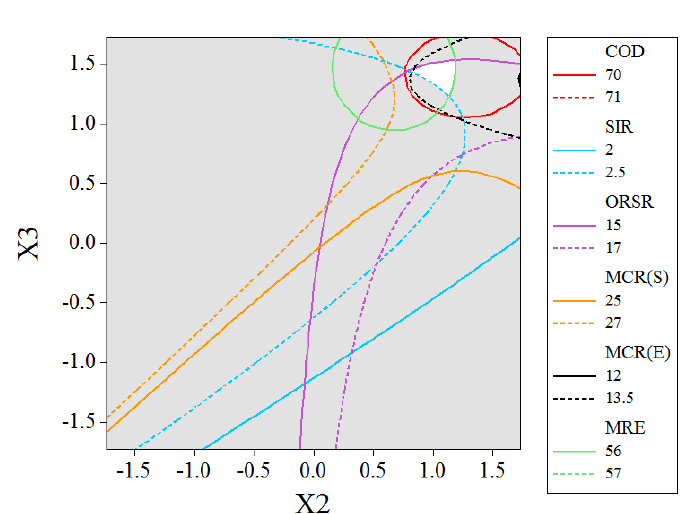
Fig. 5: The responses overlaying plot. The target areadisplayed in blank area and factors are in coded form (initial pH = 5.7)